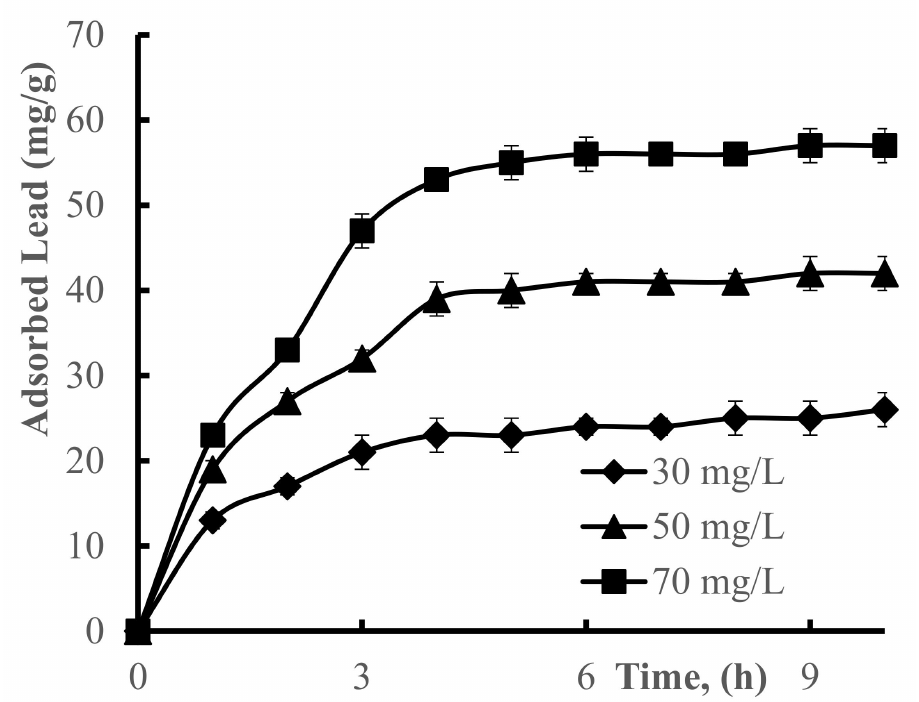
Figure 6. Pb(II) ion adsorption at different times, at various initial concentrations (30 mg/L, 50 mg/L, and 70 mg/L) of Pb(II) ions. Conditions: mass of dry hydrogel 100 mg, at 25 ◦ C. Hydrogel (50–50% DMAA–AMPS molar ratio, initiator concentration 0.07% of total monomer mass, 0.74% crosslinker, total monomer concentration 5 M) was